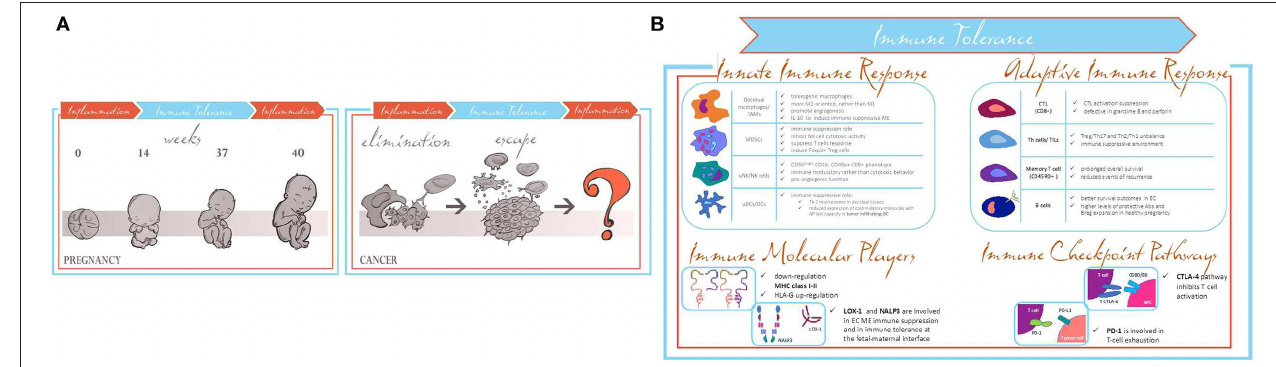
FIGURE 1 | (A) Pregnancy and cancer parallelism in switching from activation to modulation of the immune responses. (B) Common shared immune tolerance patterns in pregnancy and EC.